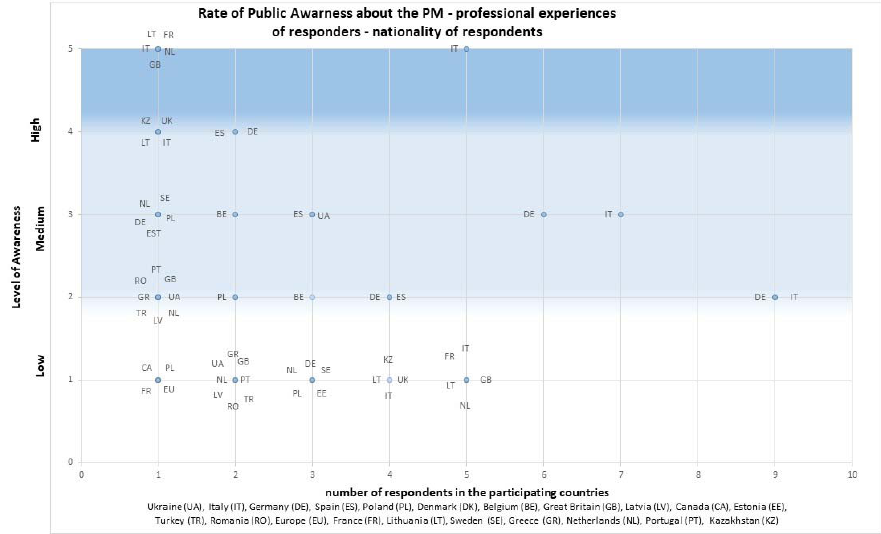
Figure 2. Rate of public awareness of PM—professional experiences of the respondents—breakdown by respondents’ nationality (survey data)—dot plot.